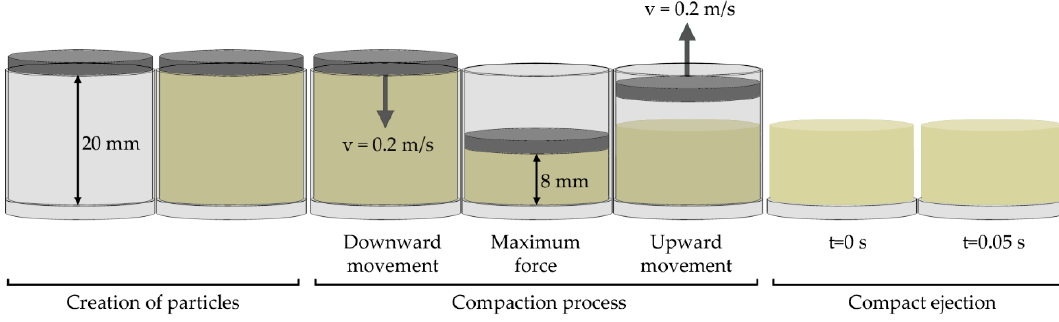
Figure 3. Scheme of the simulated process.